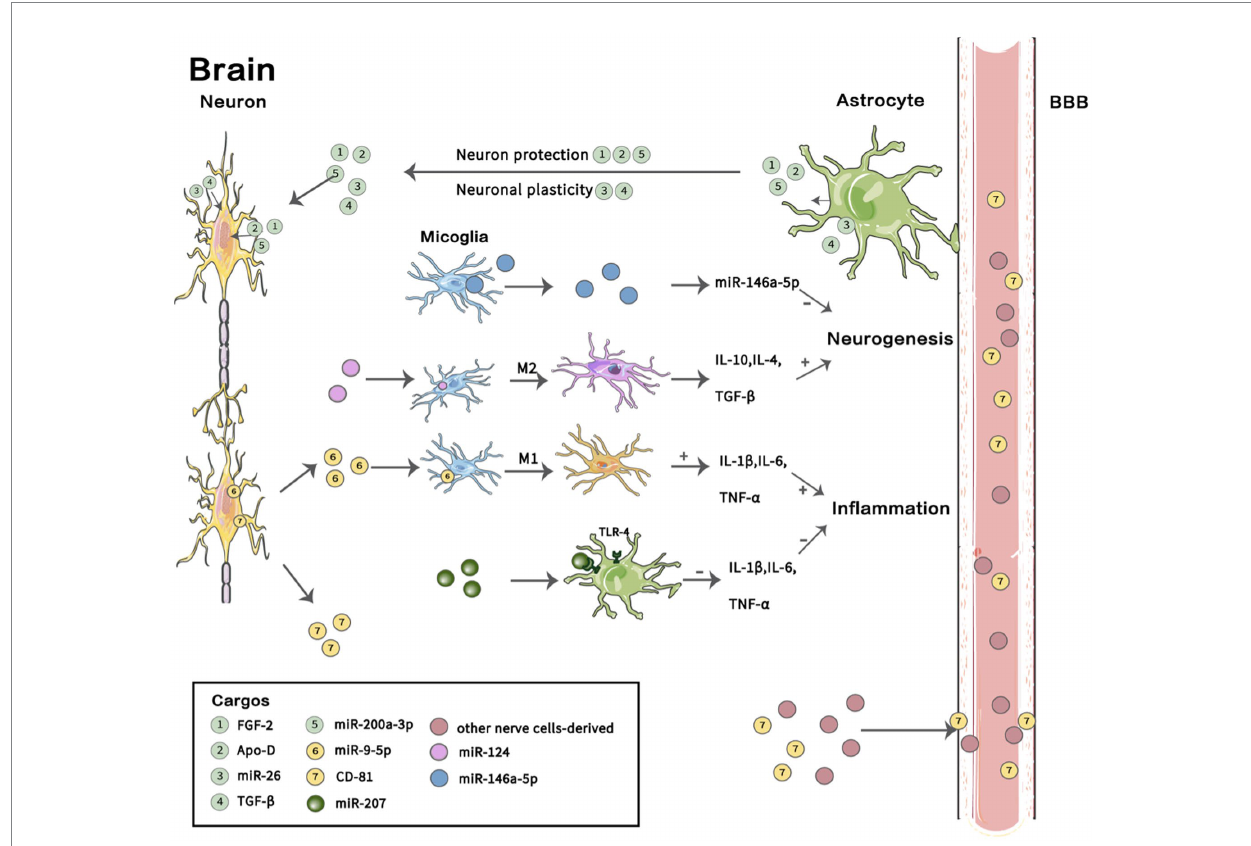
FIGURE 2 Cargos in EVs involved in the pathogenesis of MDD. In the brain, astrocytes secrete extracellular vesicles (EVs) containing FGF-2, Apo-D, and miR- 200a-3P that act on neurons and participate in neuroprotection under oxidative stress, and they also secrete EVs containing miR-26 and TGF- β , which play a role in neural plasticity. EVs containing miR-207 secreted by NK cells act on the TLR-4 receptor of astrocytes and inhibit the release of IL-1 β , IL-6 and TNF- α to reduce neuro-inflammation. Microglia undergo M1 polarization and M2 polarization, thus participating in different pathophysiological processes. EVs secreted by microglia containing miR-146a-5P can inhibit neurogenesis. EVs with miR-9-5P promote M1 microglia polarization and release IL-4, IL-10 and TGF- β to support neurogenesis; however, EVs containing miR-26 induce M2 polarization of microglia and release the pro- inflammatory factors IL-1 β , IL-6 and TNF- α to promote inflammation. Brain-derived EVs transfer to the periphery through the blood–brain barrier (BBB), and abnormal expression of some proteins and miRNAs was found in neuron-derived EVs in plasma. A summary of several previous findings described in this review is shown. BBB, blood–brain barrier; FGF-2, Fibroblast growth factor 2 ； Apo-D, Apolipoprotein D; TGF- β , transforming growth factor- β . Images for these figures were adapted from Servier Medical Art (by Servier; https://smart.servier.com/), licenced under CC BY 3.0 (https://